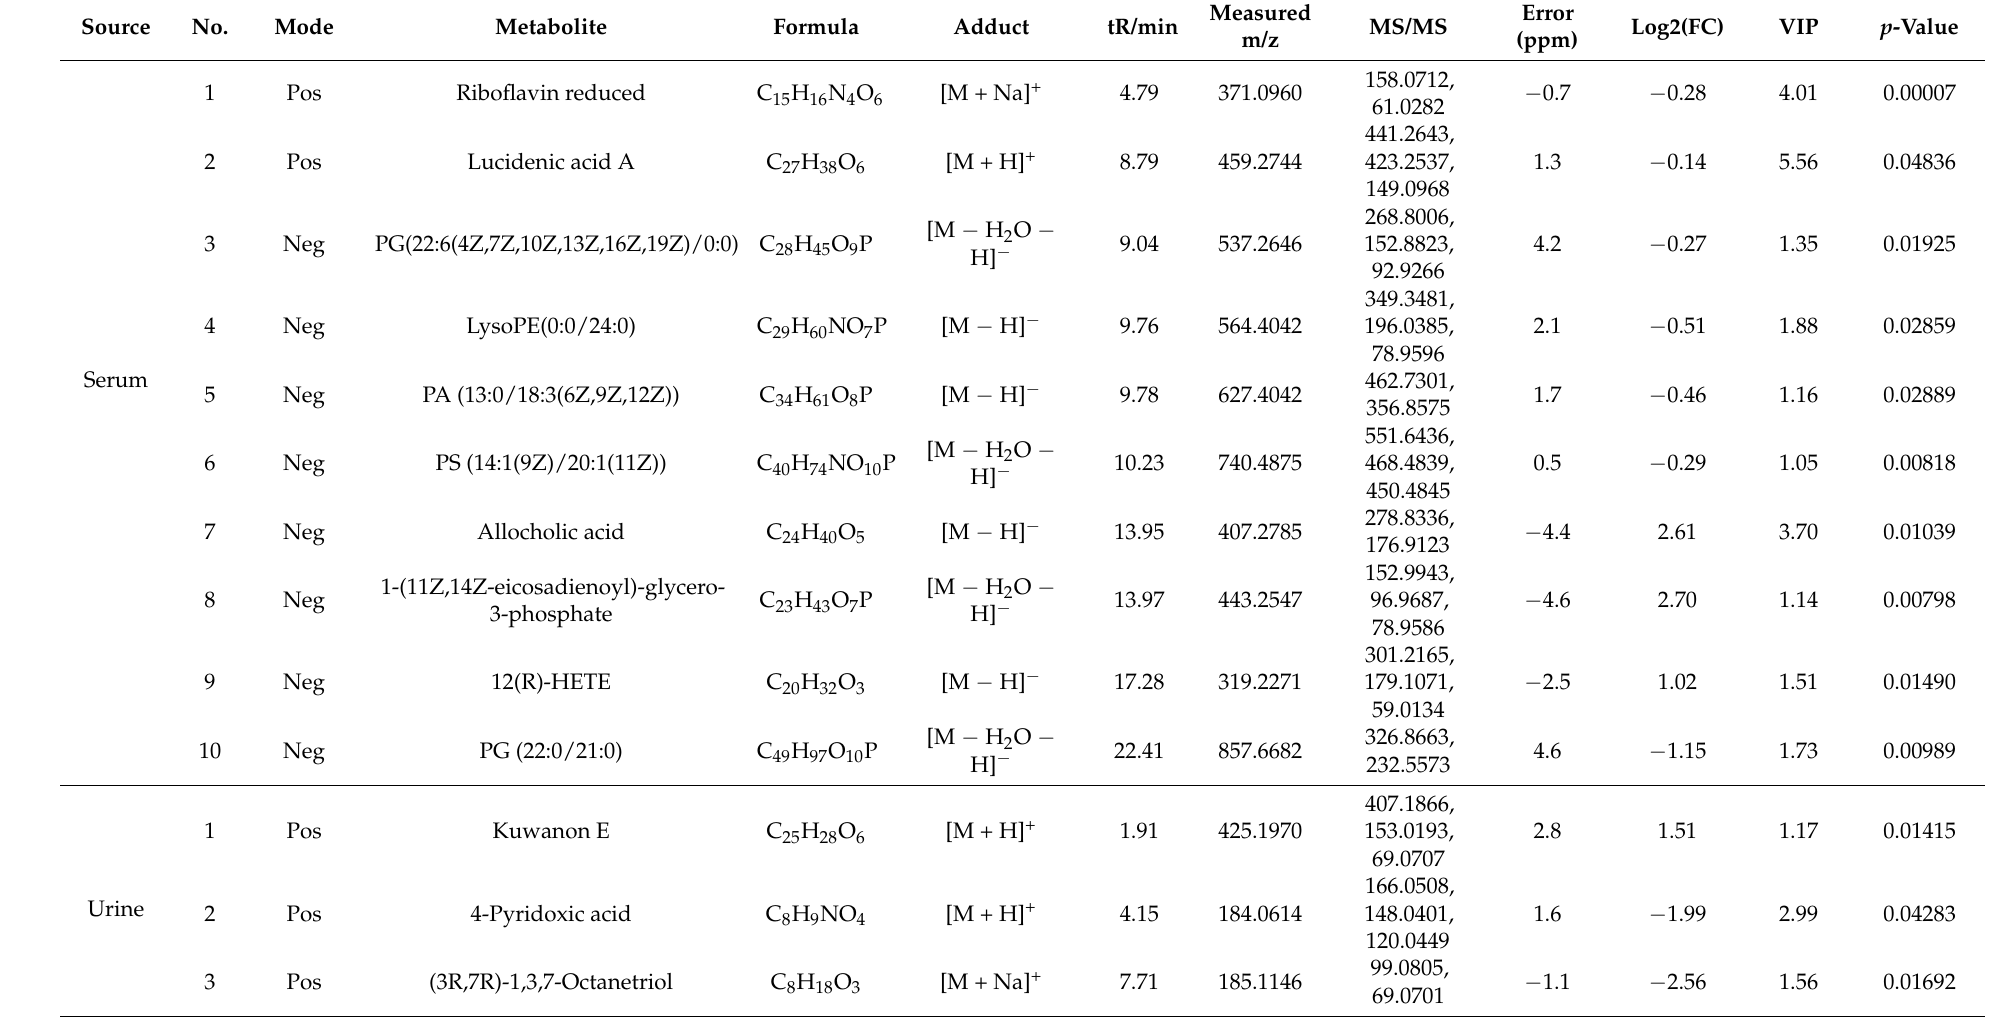
Table 2. Identification results of differential metabolites in T2DM vs. ginsenoside Re group in serum and